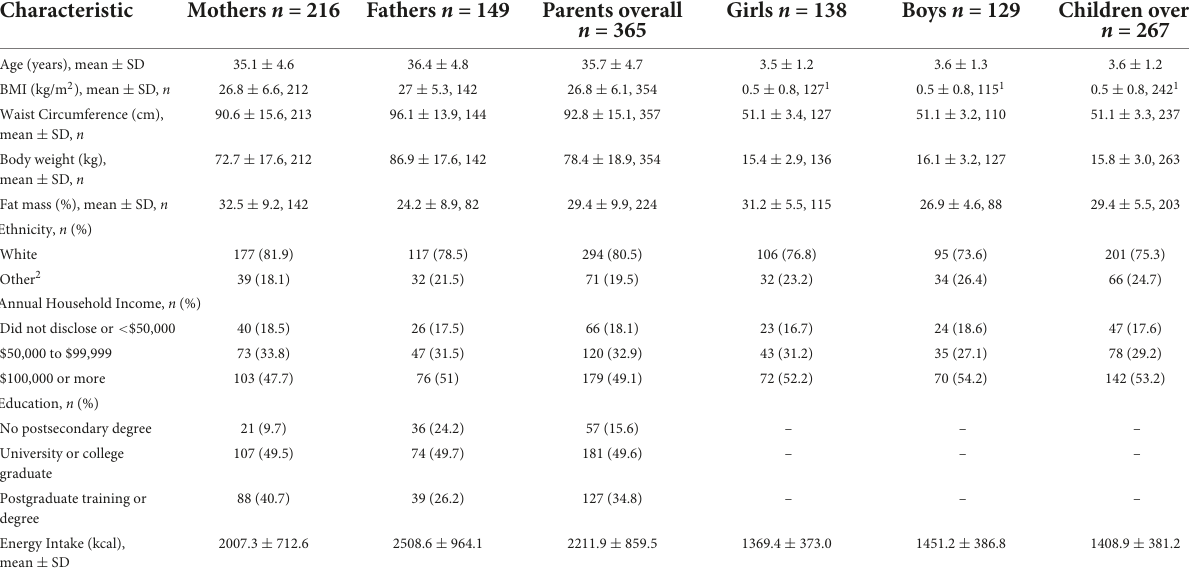
EnergyIntake(kcal), mean ±